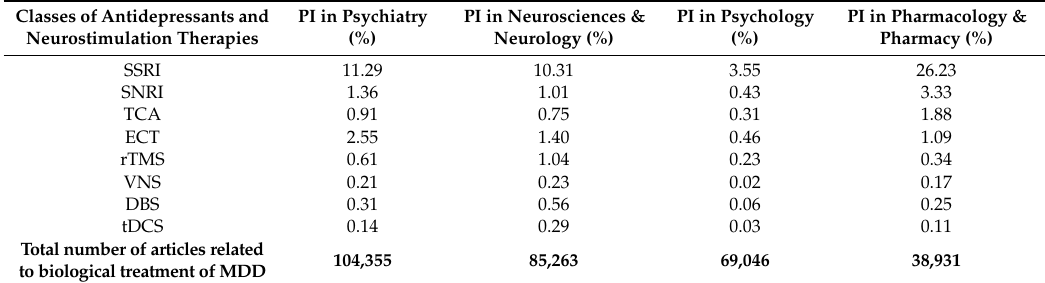
Table 2. The PI for di ff erent classes of antidepressants and 5 neurostimulation therapies in di ff erent sub-specialties.